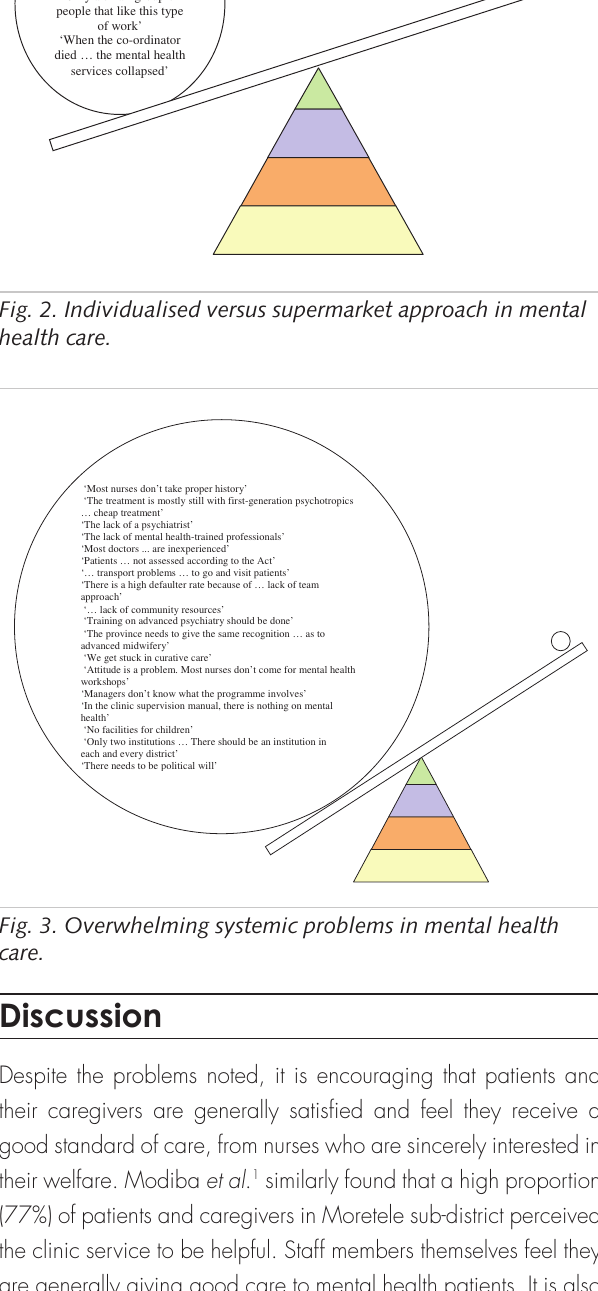
Fig. 2. Individualised versus supermarket approach in mental health care.